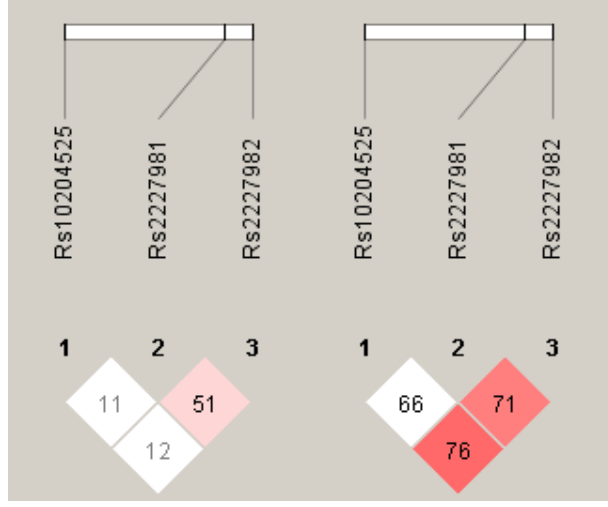
Table 6. Association of PD-1 haplotypes with CRC in Saudi Arabia.